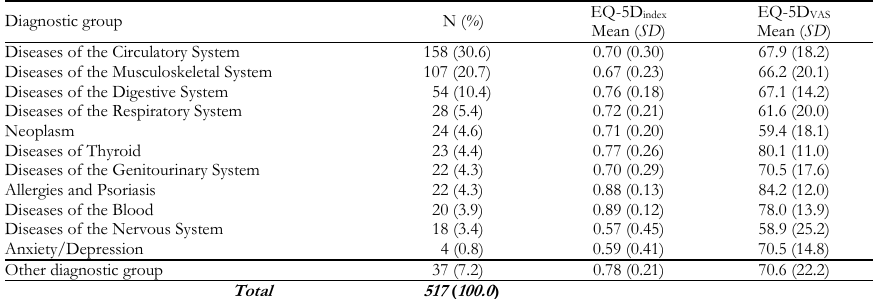
Diagnostic group of the most common self-reported health conditions and EQ-5D index mean and standard deviation